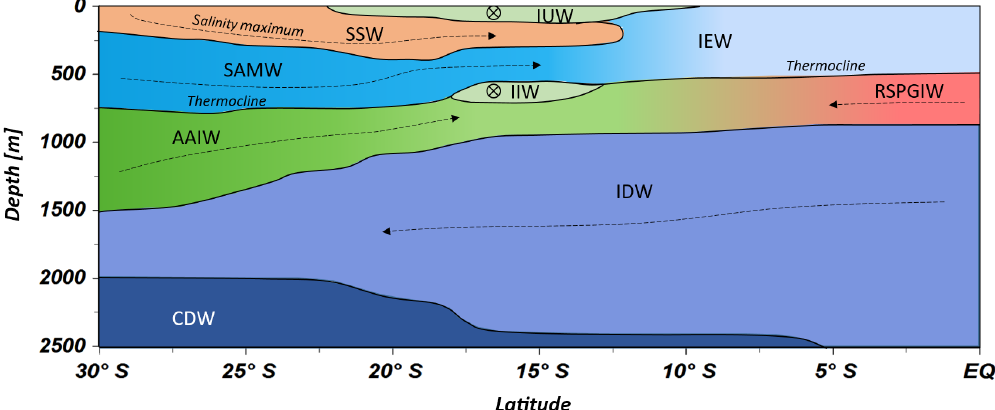
Figure 6. Water mass distribution model from 30 ◦ S to the Equator. The CTD stations taken into account for this transect ranged between 67.07 and 77.16 ◦ E. Dotted lines represent N–S current directions and circled crosses indicate latitudinal directions from E to W. For water mass abbreviations see Table